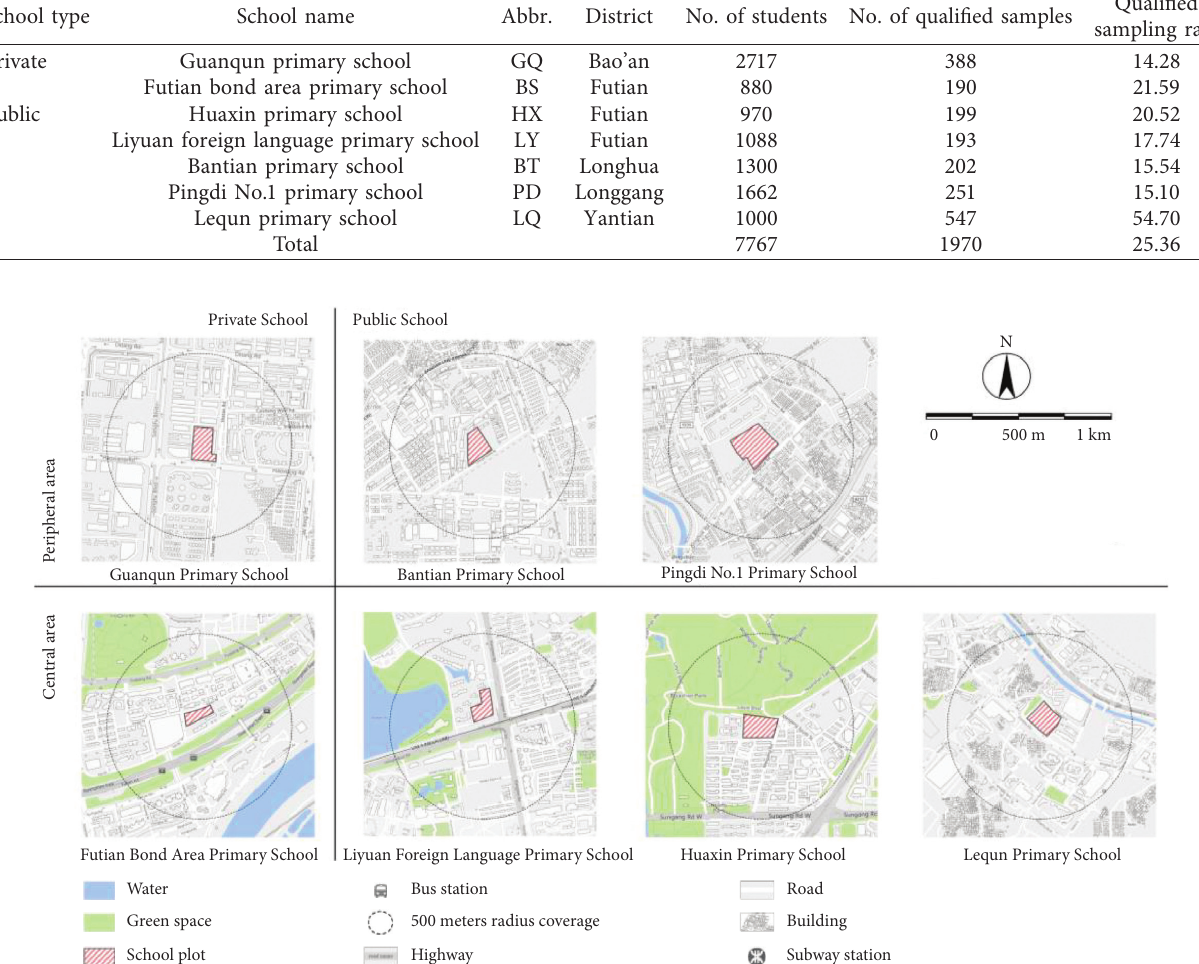
Figure 3: School-around built environment.